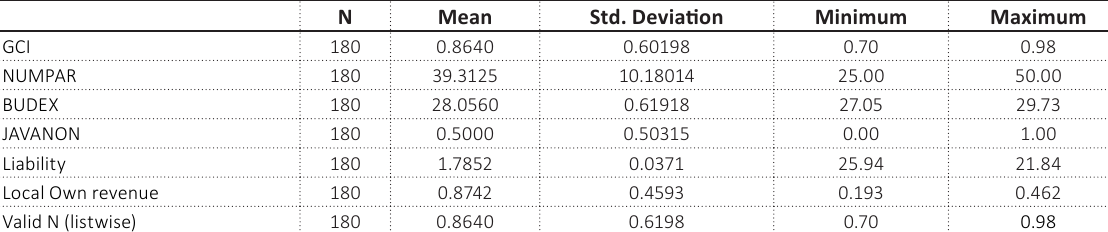
Table 3. Independent variable in descriptive statistics